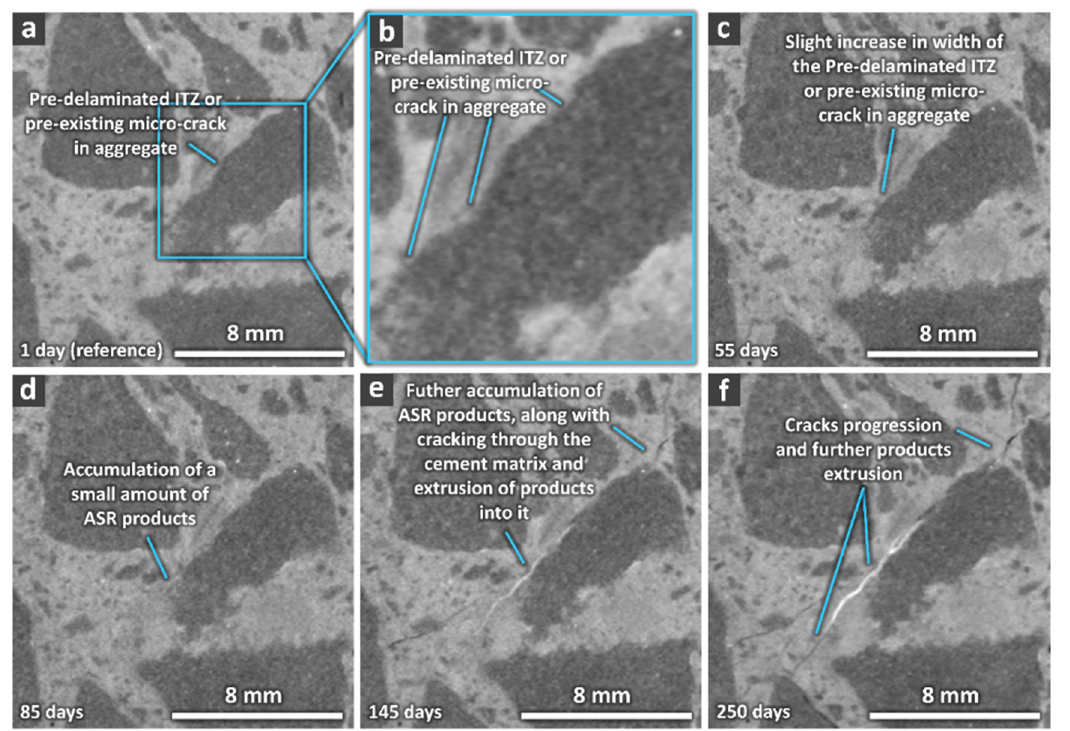
Figure 15. 2D cross ‐ section ("slice") from a 3D ROI of the (registered) time ‐ lapse X ‐ ray tomograms of a specimen cast with U aggregates (calcareous sandstone, see S5.1) and with BaSO 4 and CsNO 3 as contrast enhancers. ASR products are visible as very bright regions, because of Cs ‐ doping, within cracks and near the aggregate boundaries. The slices shown here are from the tomograms at (a) and (b) 1 day, (c) 55 days, (d) 85 days, (e) 145 days and (f) 250 days from the start of the ASR acceleration protocol.